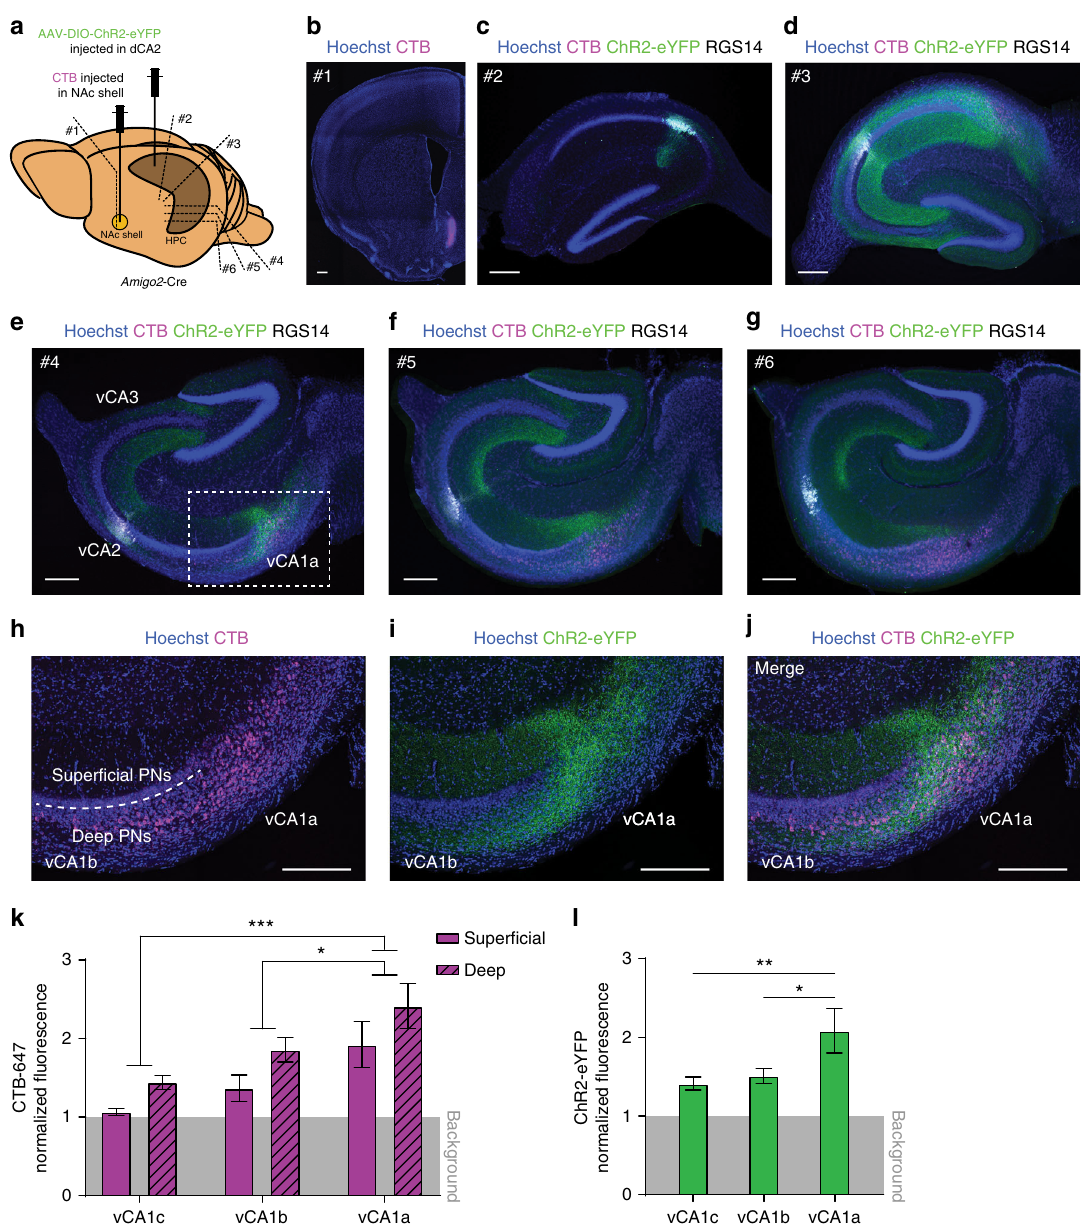
Fig. 5 dCA2 targets a vCA1 site containing PNs that project to the NAc shell. a AAV-DIO-ChR2-eYFP was injected in dCA2 and the retrograde label CTB- 647 was injected into the NAc shell of Amigo2 -Cre mice. Approximate location of sections in b , c , d , e , f , and g are indicated (position #1, #2, #3, #4, #5, and #6, respectively). b Site of injection of CTB-647 (magenta). c Dorsal HPC section showing ChR2-eYFP (green) expression in dCA2 PN cell bodies (co- expressing RGS14, white) with no CTB-647 staining (lack of magenta). d Transverse section of intermediate HPC showing dCA2 fi bers (labeled with ChR2- eYFP, green) distributed throughout CA3 and CA1 and sparse CTB-647 labeling (magenta). e – g Transverse sections progressing through vHPC showing dCA2 fi bers (green) in vCA3, distal vCA1 (vCA1a) and adjacent ventral subiculum. Retrograde CTB-647 labeling of projections to NAc shell is seen in deep distal vCA1 (vCA1a) and adjacent ventral subiculum (magenta). h – j High magni fi cation views of dotted area in e . k Quanti fi cation of normalized CTB-647 fl uorescence in deep versus super fi cial PNs cell layers in vCA1c, vCA1b, and vCA1a. Ventral CA1 fl uorescence was greater in deep versus super fi cial layers ( n = 9 slices, 3 mice, repeated measures two-way ANOVA: deep/super fi cial F (1,8) = 55.05, P < 0.0001). Fluorescence was greater in distal (vCA1a) versus more proximal (vCA1b and vCA1c) areas ( n = 9 slices, 3 mice, repeated measures two-way ANOVA: proximal-distal F (2,16) = 14.96, P = 0.0002, vCA1a vs vCA1b P = 0.0135, vCA1a vs vCA1c P = 0.0002, vCA1b vs vCA1c P = 0.1404, Tukey ’ s multiple comparisons test). l Quanti fi cation of normalized fl uorescence intensity of ChR2-eYFP signal in dCA2 projections in vCA1. Signal was more intense in vCA1a compared to vCA1b and vCA1c ( n = 9 slices, 3 mice, repeated measures one-way ANOVA: F (2,16) = 7.058, P = 0.0063, vCA1a vs vCA1b P = 0.0231, vCA1a vs vCA1c P = 0.0083, vCA1b vs vCA1c P = 0.8702, Tukey ’ s multiple comparisons test). Results in k and l show mean ± s.e.m. * P < 0.05; ** P < 0.01; *** P < 0.001. Scale bars, 250 µ